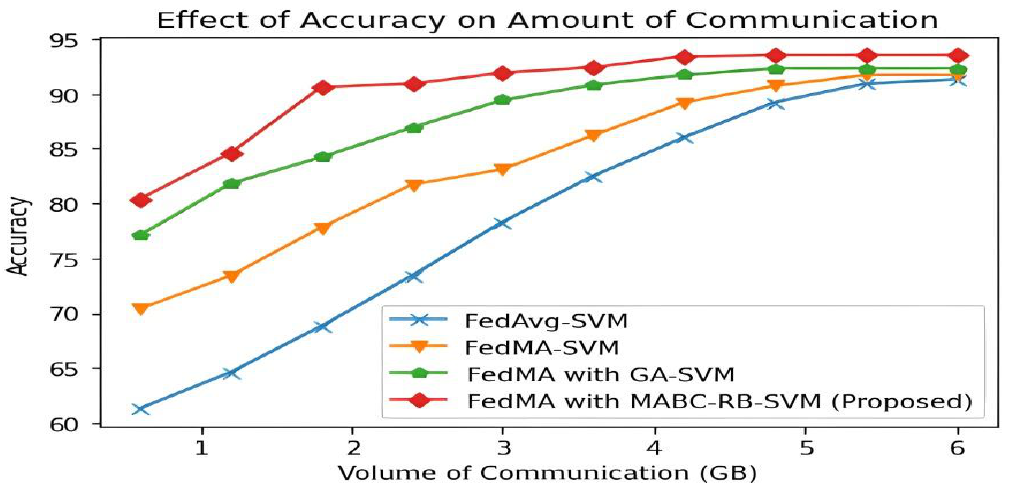
Figure 5. Analysis of prediction accuracy on the volume of communication.